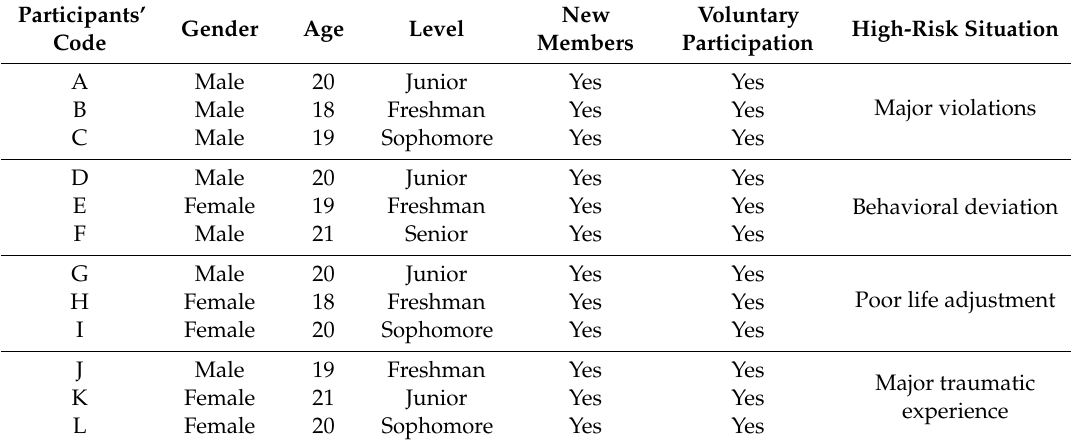
Table 1. Background and grouping of the drama therapy student